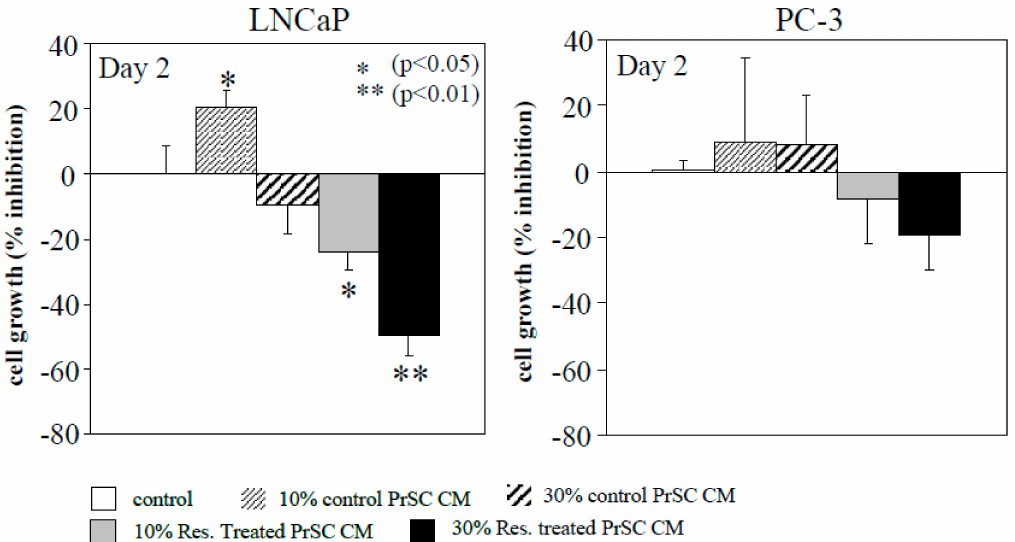
Figure 1. Conditioned media (CM) from prostate stromal cells (PrSC), with and without treatment by resveratrol, selectively inhibited growth of LNCaP cells. CM were obtained from control and 72 h resveratrol-treated PrSC, and added to LNCaP and PC-3 cells. CM-treated cells were harvested at 48 h and growth was monitored by trypan blue exclusion. Number of experiments: n = 6 for LNCaP cells; n = 3 for PC-3